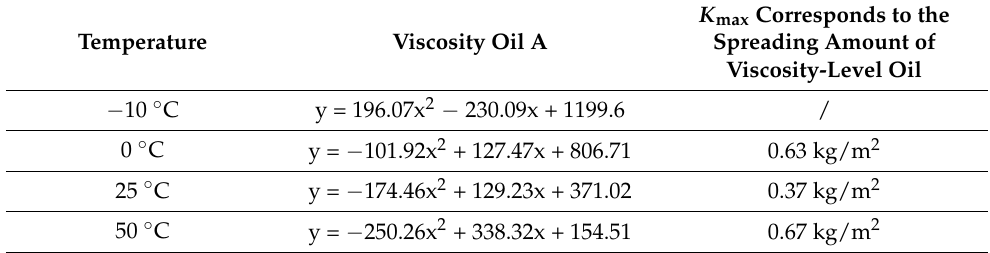
K max Corresponds to the Spreading Amount of Viscosity-Level